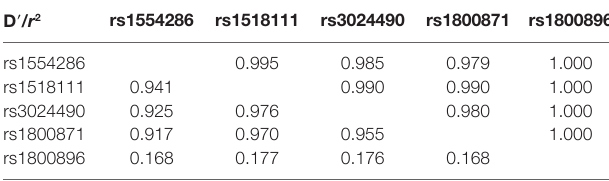
TaBle 4 | The linkage disequilibrium among the SNPs in IL-10.